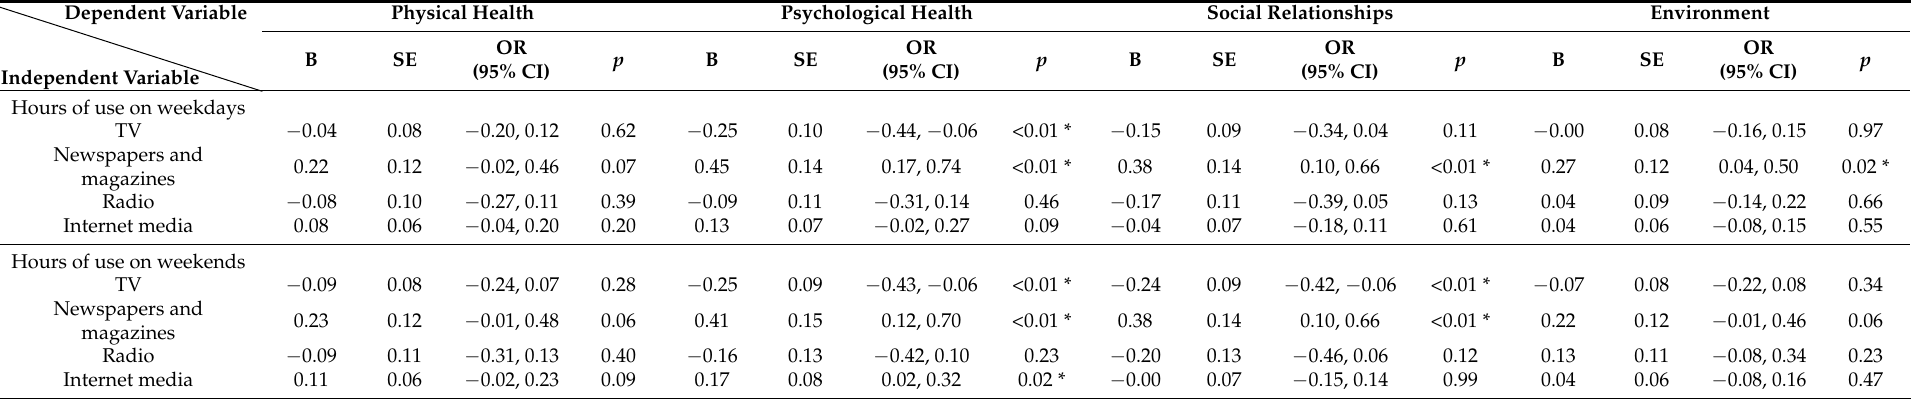
Table 5. Multiple regression analysis for identifying that the WHOQOL-BREF is significantly related to the hours of media usage on weekdays † /weekends † .